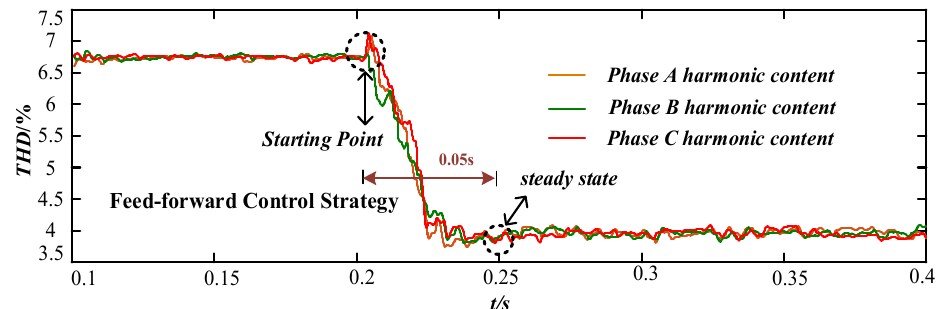
Figure 9. The harmonic change under the current feed-forward control strategy.